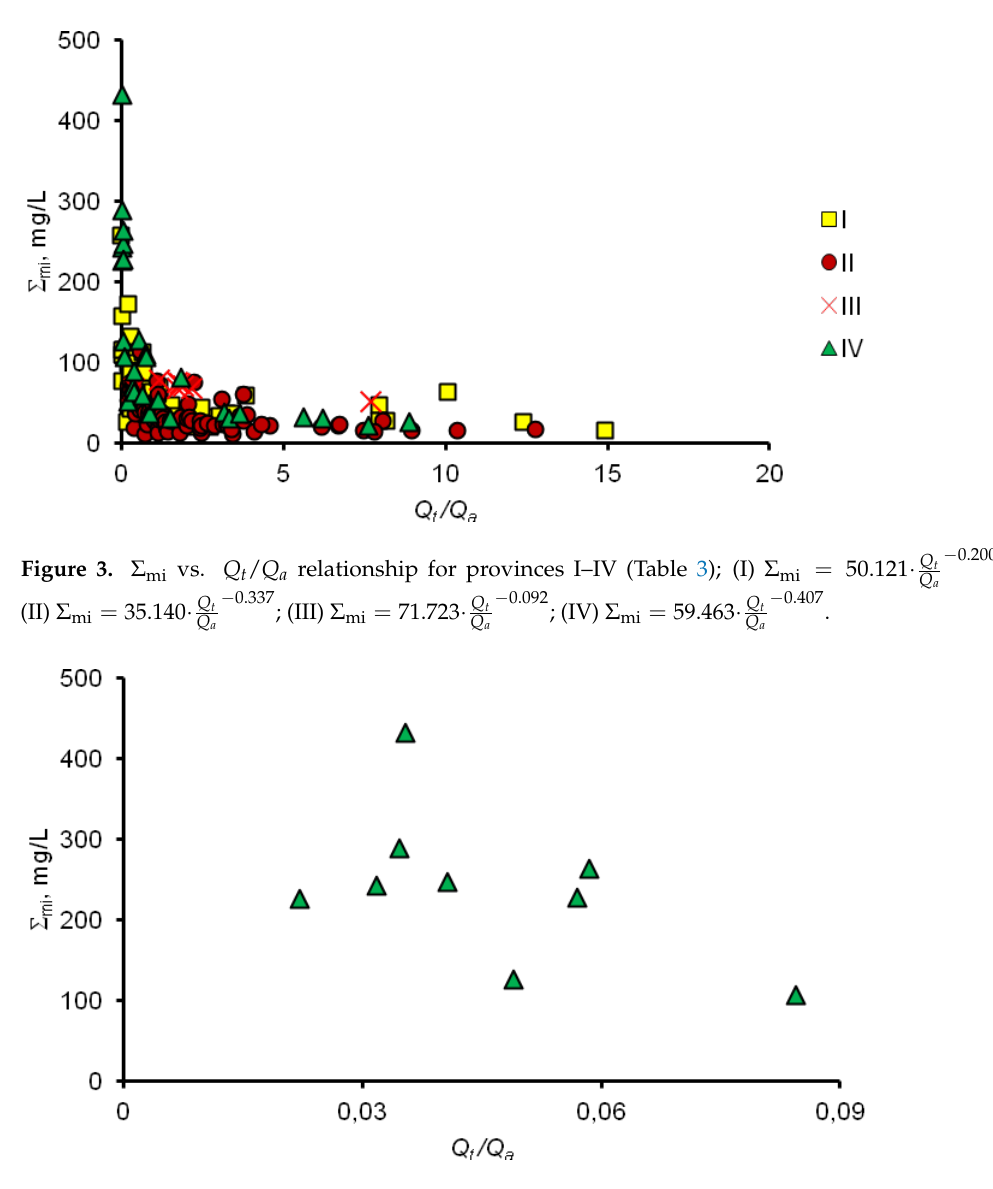
− 0.092 ; (IV) Σ mi = 59.463 · Q t Q a